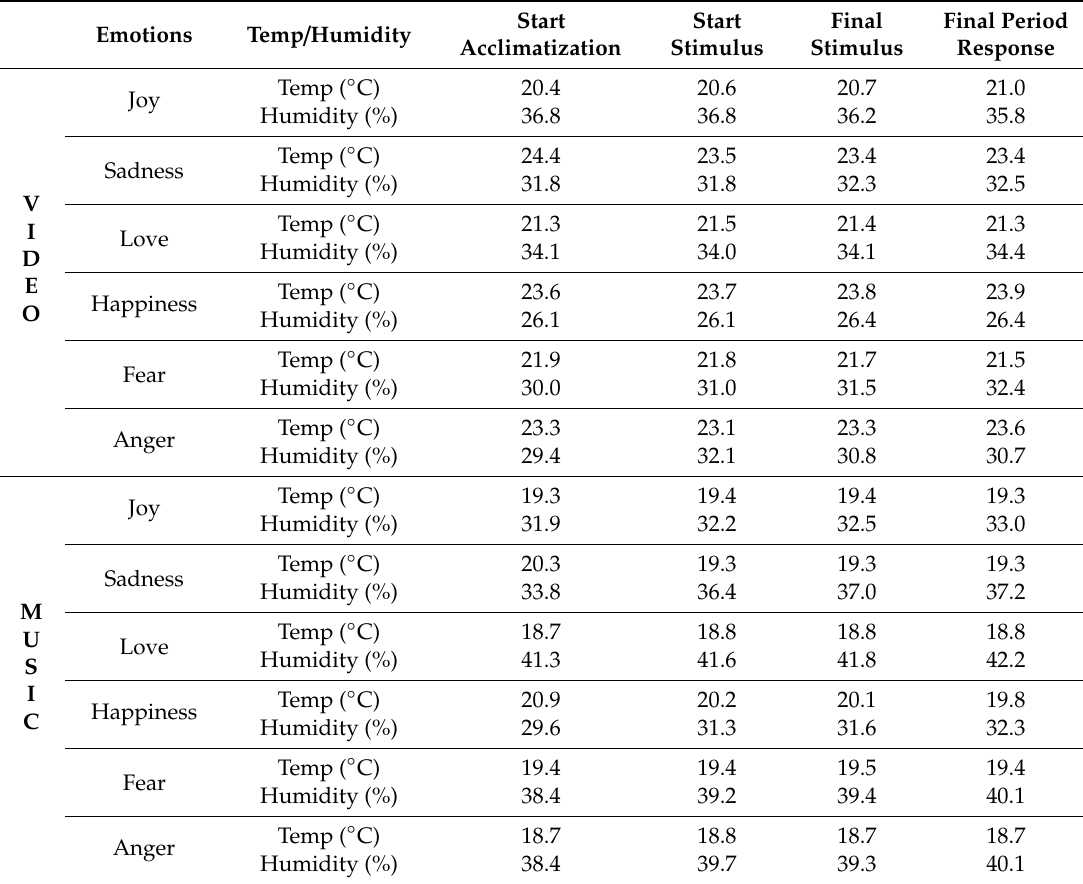
Table 2. Environmental conditions of each session.